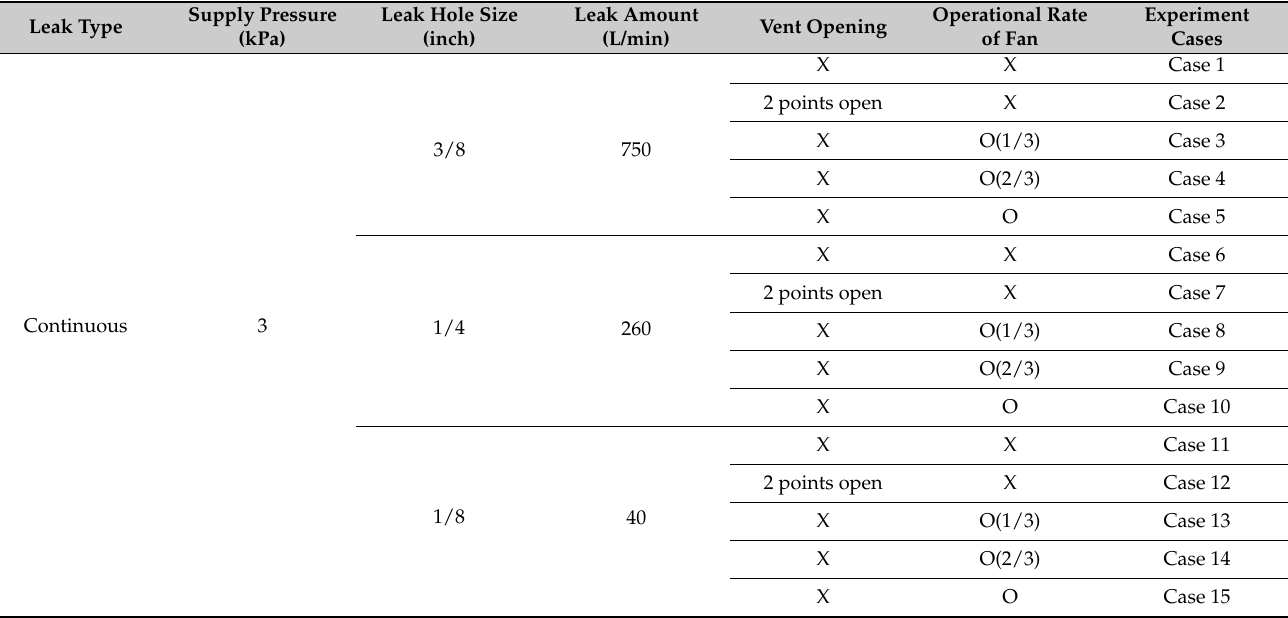
Table 3. Experimental